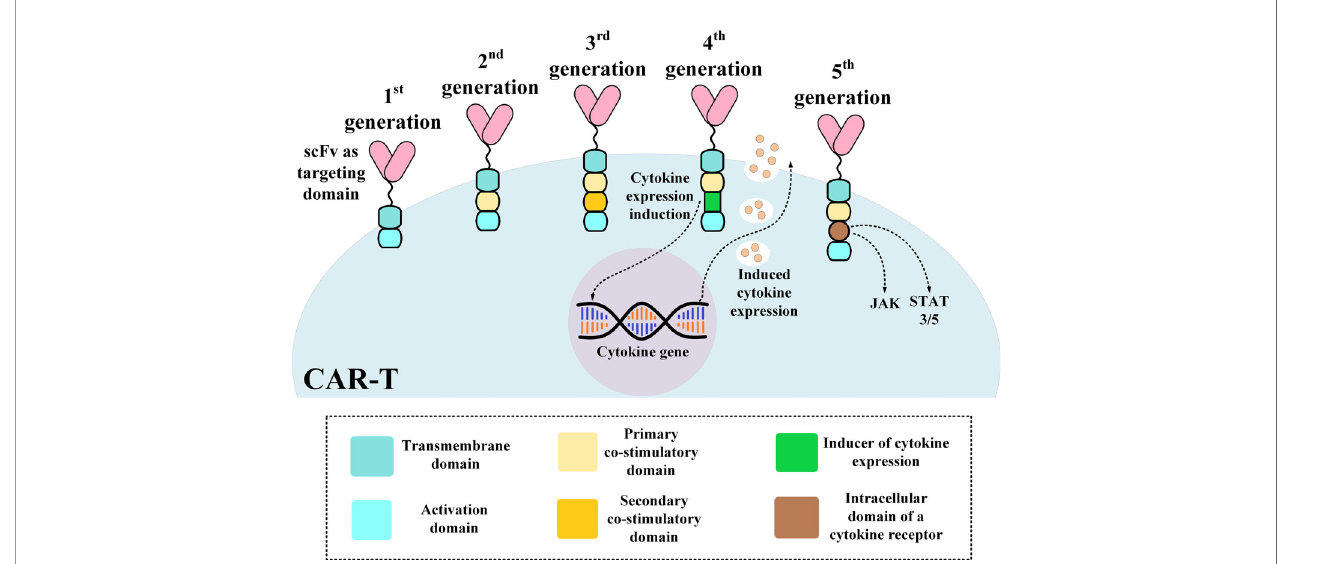
FIGURE 1 | An illustration of different CAR-T generations. CAR, chimeric antigen receptor; scFv, single-chain variable